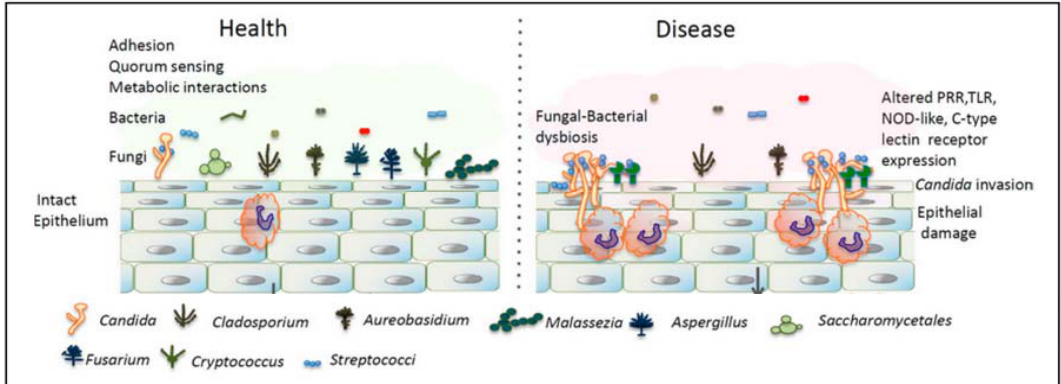
Figure 2. Differences in the mycobiota in the oral cavity in health and disease. A dysbiotic state of C andida overgrowth causes epithelial damage. Adapted from [39] with